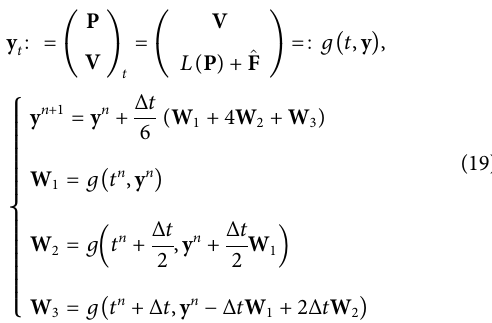
TABLE 1 The maximum Courant numbers for the MSDG, SDG and CDG methods.